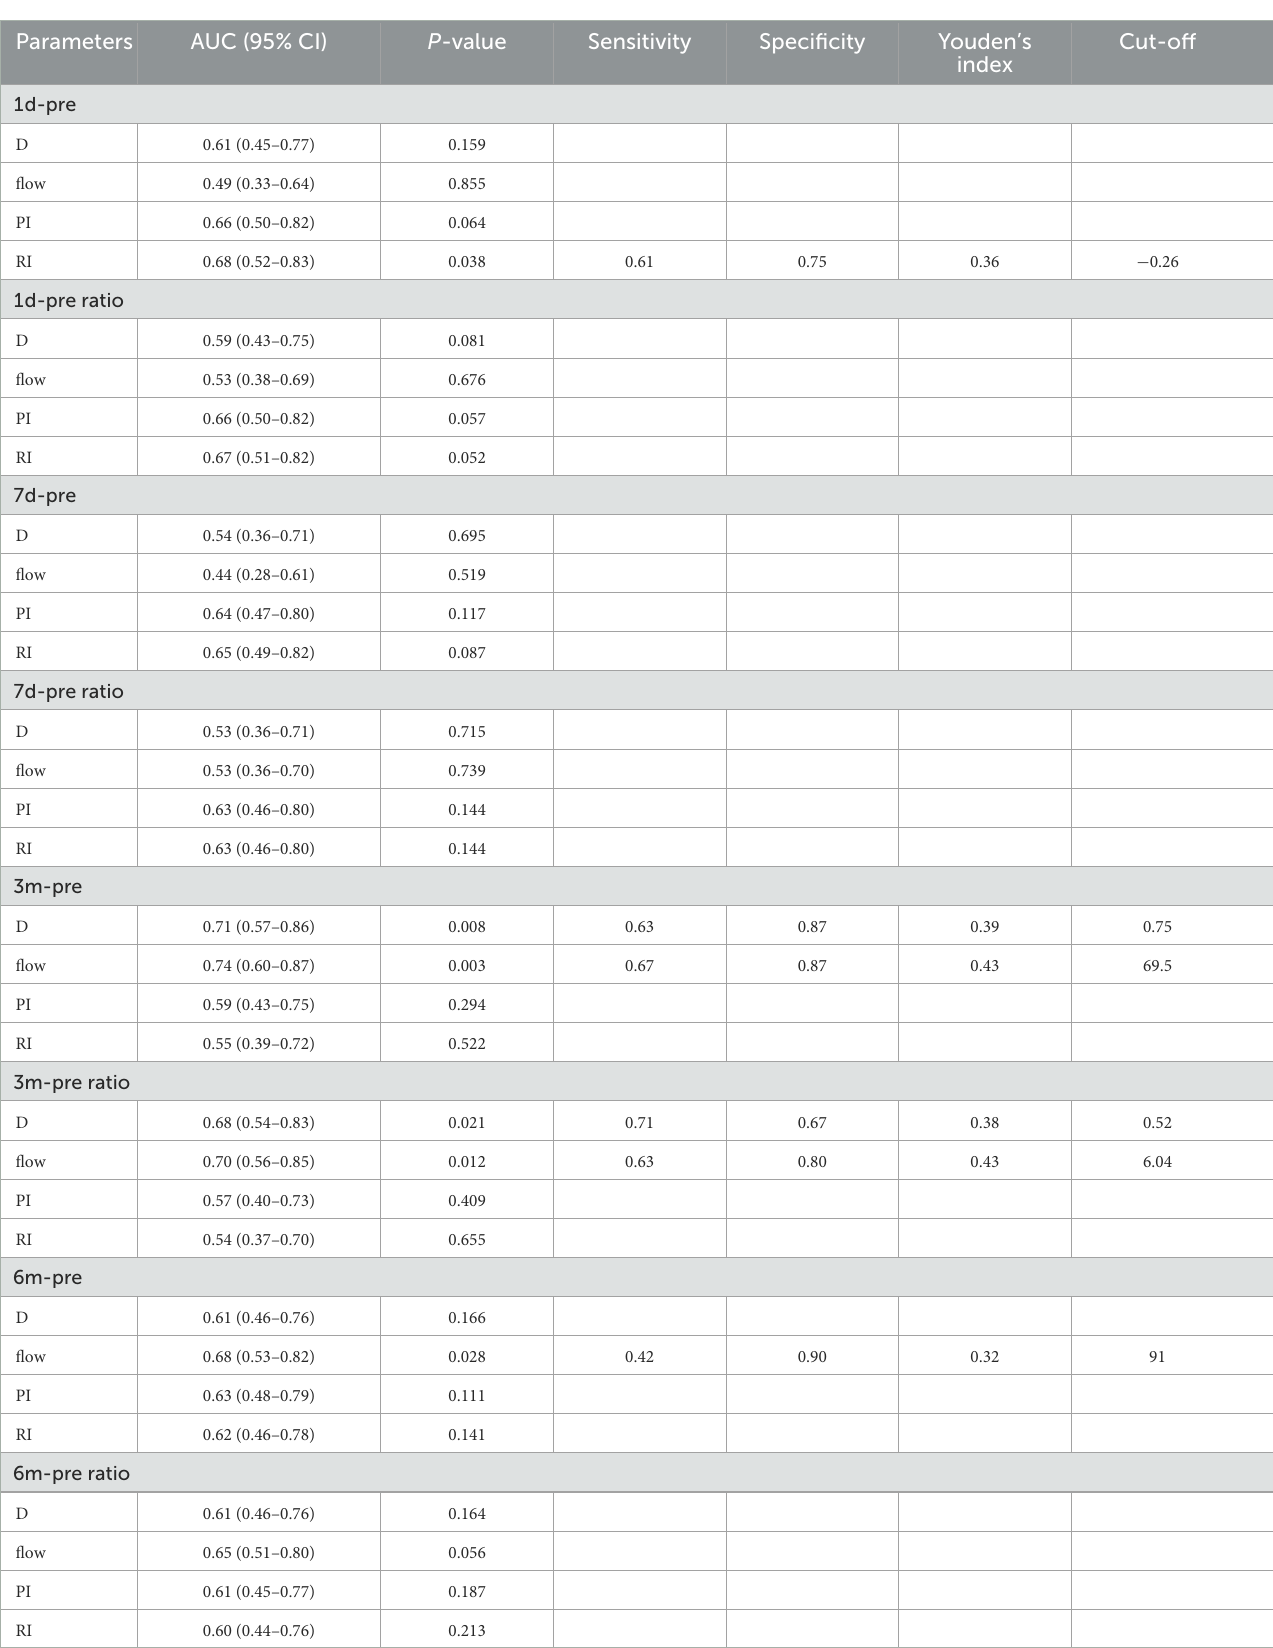
TABLE 4 Pre-operative hemodynamic parameters as the baseline to determine cut-off points for parameter changes corresponding to poorly-compensated collateral group (P group) by receiver operating characteristic (ROC) analysis.